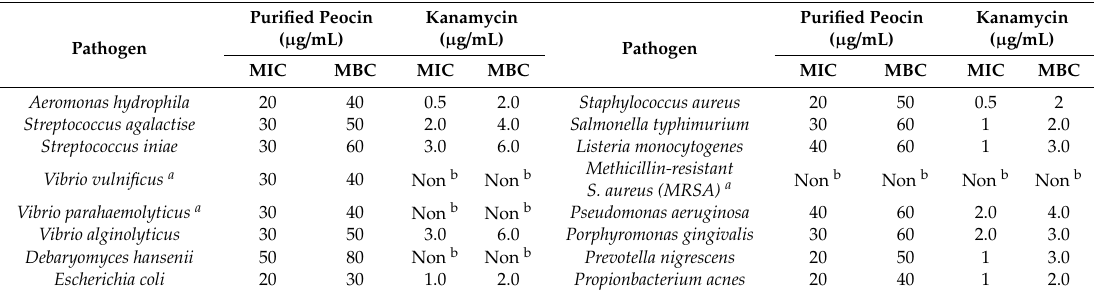
Table 2. Antimicrobial activity of purified peocin and antibiotics against diverse